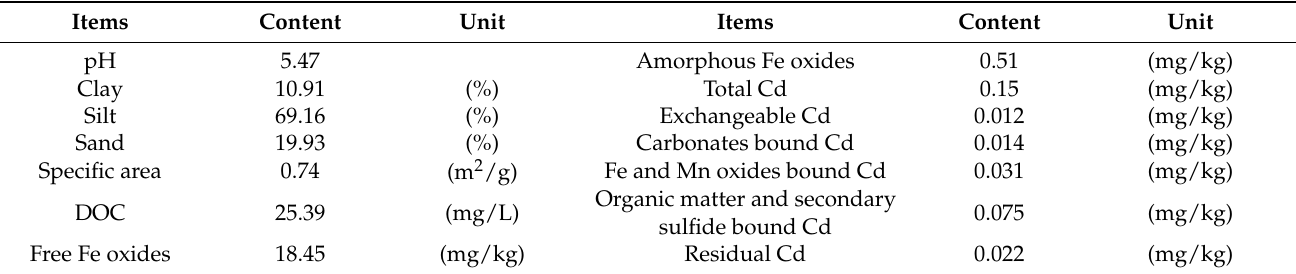
Table 1. The physicochemical properties of the soils in this study.